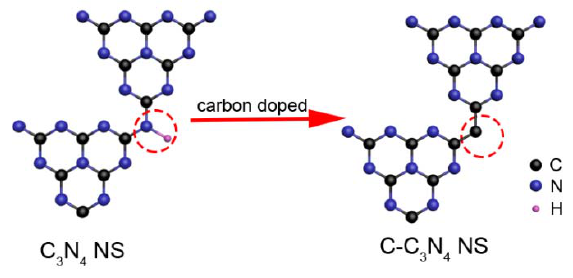
Figure 5. Atomic structure of C 3 N 4 NS and C ‐ C 3 N 4 NS.